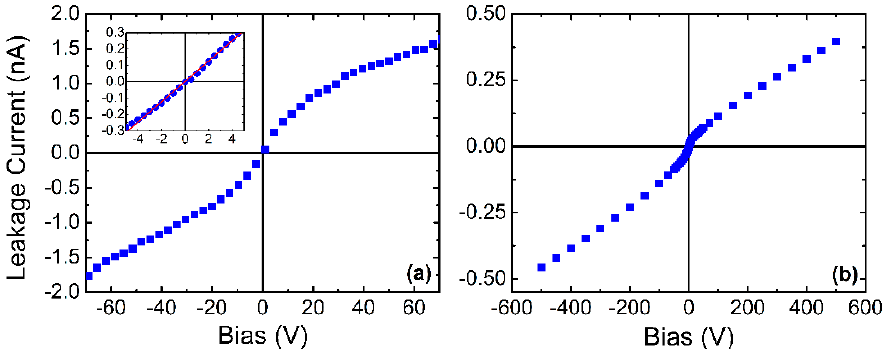
Figure 11. Current voltage ( I-V ) characteristics as obtained using a VBM grown ( a ) and THM grown ( b ) Cd 0.9 Zn 0.1 Te 0.97 Se 0.02 planar detector. The I-V characteristics of the THM detector have been reproduced with permission from ref. [49]. Copyright 2021, IEEE. The inset in ( a ) shows the low-range I-V plot for resistivity calculations.